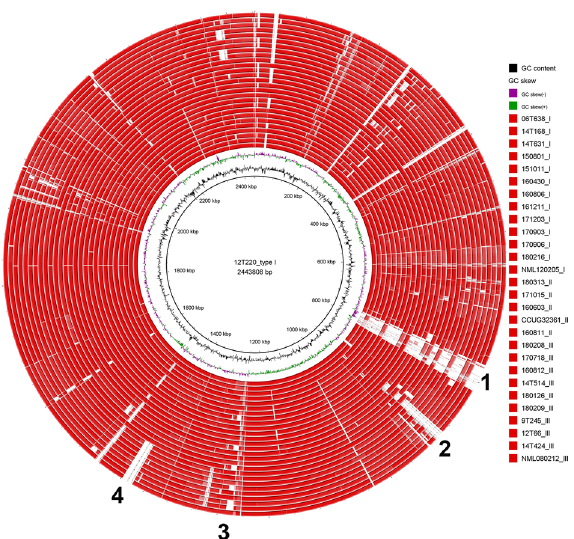
Figure 2. Visualization of the comparison of all C. macginleyi genomes. Strain 12T220 was taken as reference genome. The analysis revealed strong overall synteny. Only a few genomic islands were present, such as a prophage (labeled as 1), two islands that were absent in all clade II strains but present in most clade I strains (labeled as 2 and 4), and an island containing the CRISPR/cas gene cluster (labeled as